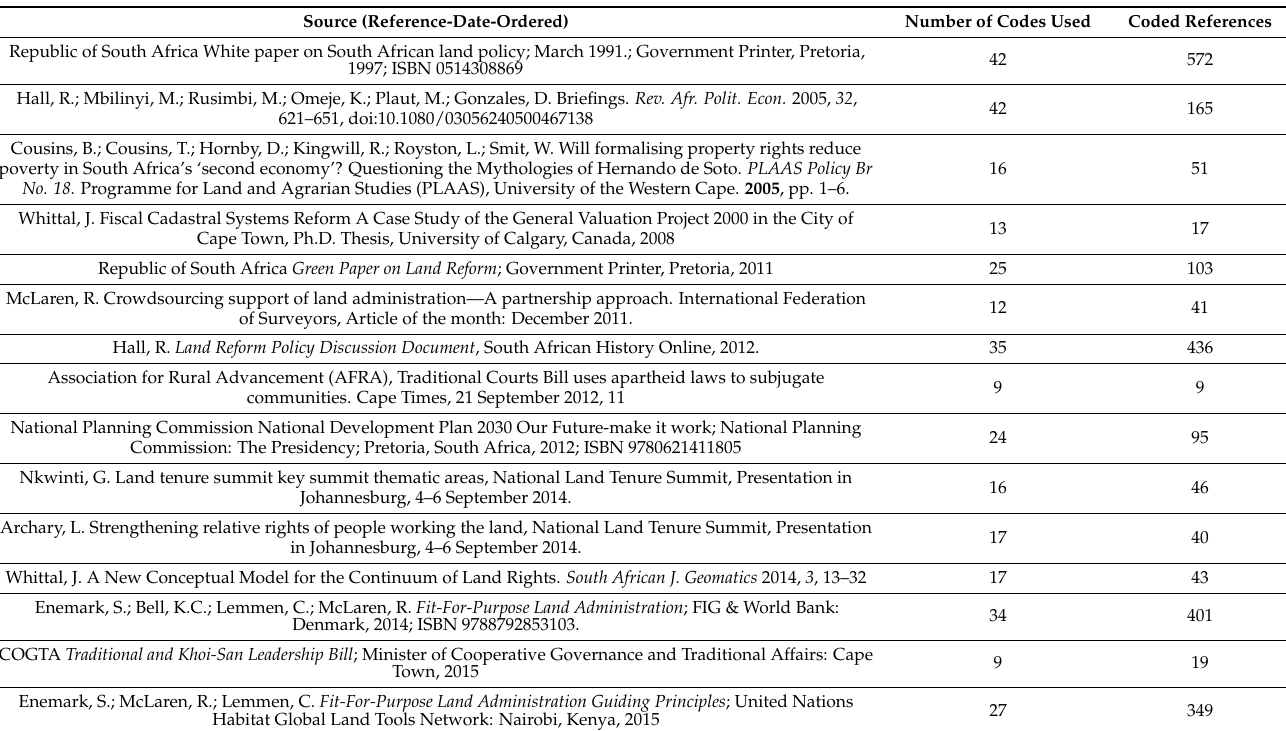
Table A1. Sources Coded in